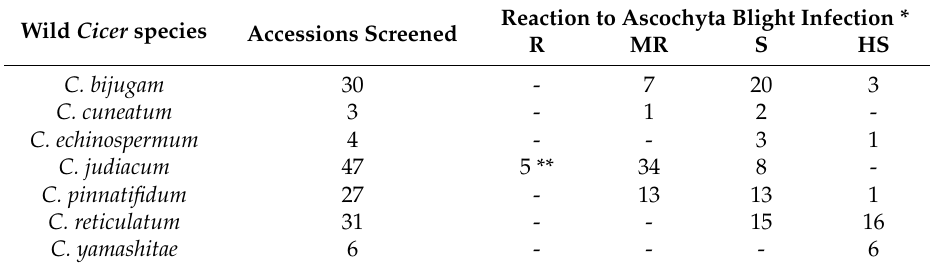
Table 1. Reaction of wild Cicer species to Ascochyta blight in controlled environment screening at ICRISAT, Patancheru,